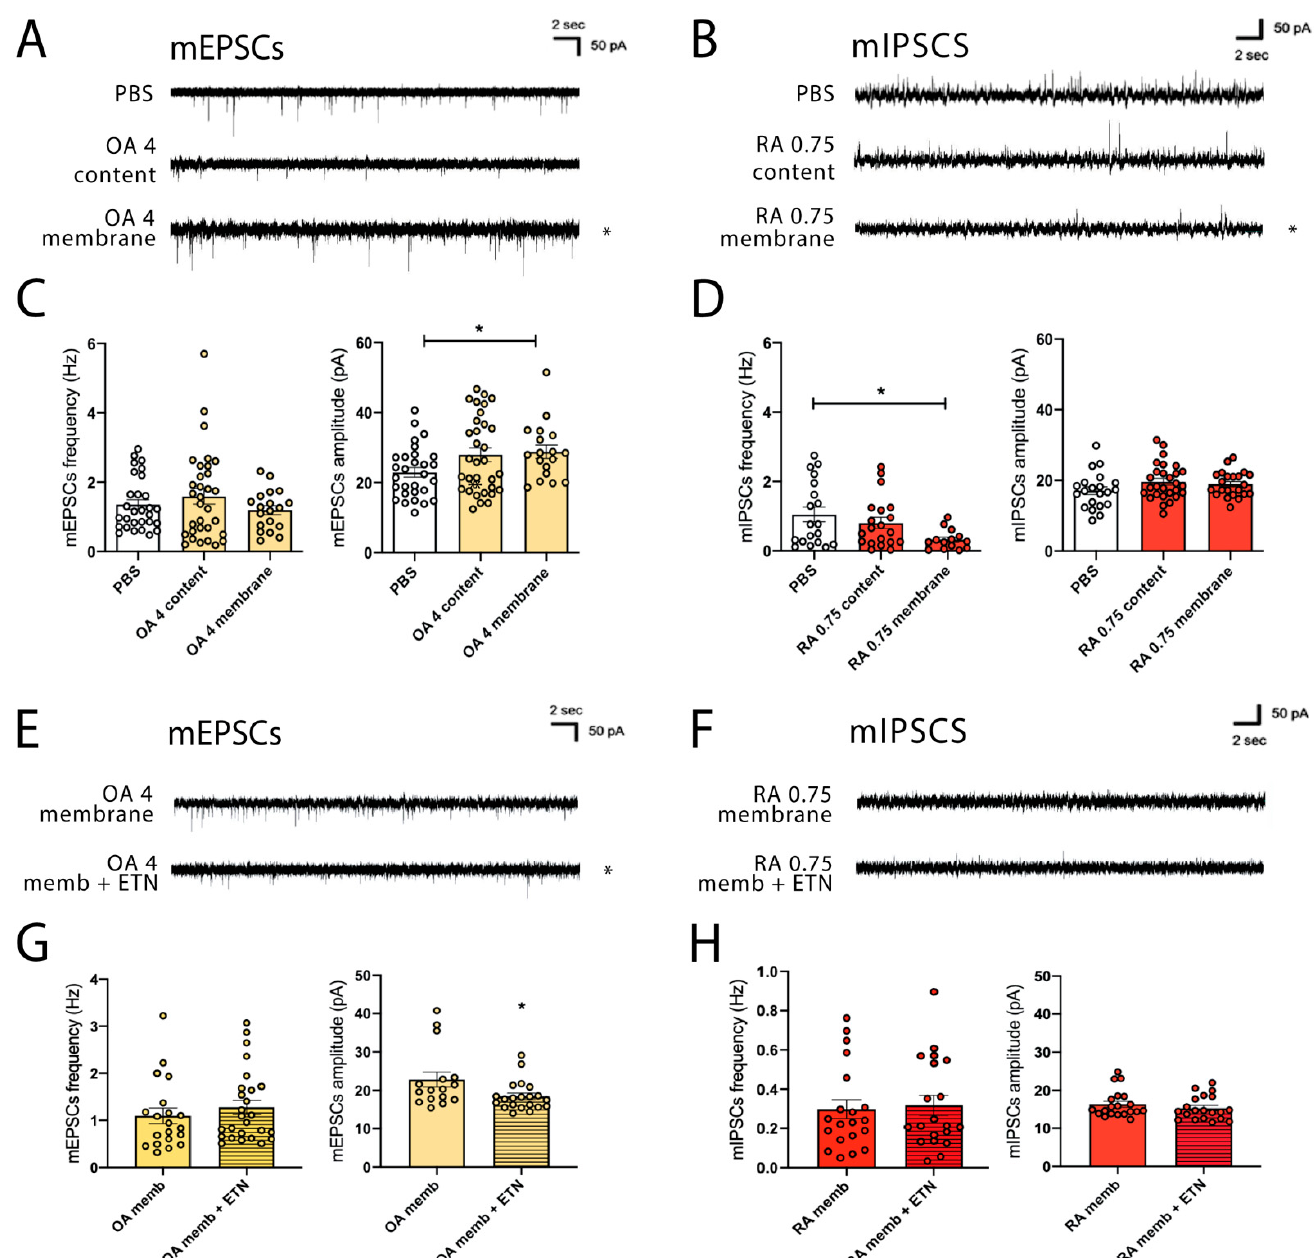
Figure 4. EVs membranes contribute to synaptic alterations. ( A ) Representative traces of mEPSCs recorded in 14 DIV hippocampal neurons obtain after two hours of exposure to OA-EVs content and membrane at high concentration. ( B ) Representative traces of mIPSCs recorded in 14 DIV hippocampal neurons obtain after two hours of exposure to RA-EVs content and membrane at low concentration. ( C ) Analysis of mEPSCs frequency and amplitude recorded after two hours of exposure to OA-EVs content and membrane at high concentration from cultured neurons. No differences in terms of frequency were detected, whereas OA-EVs membranes increase mEPSCs amplitude (frequency: Kruskal–Wallis test followed by Dunn’s multiple comparison test, ns; number of recorded neurons: PBS = 29, OA content = 32, OA membrane = 19; amplitude: Kruskal–Wallis test followed by Dunn’s multiple comparison test, * p < 0.05; number of recorded neurons: PBS = 29, OA content = 32, OA membrane = 18). ( D ) Analysis of mIPSCs frequency and amplitude recorded after two hours of exposure to RA-EVs content and membrane at low concentration from cultured neurons. No differences in terms of amplitude were detected, whereas RA-EVs membranes decrease mIPSCs frequency (frequency: Kruskal–Wallis test followed by Dunn’s multiple comparison test, * p < 0.05; number of recorded neurons: PBS = 19, RA content = 20, RA membrane